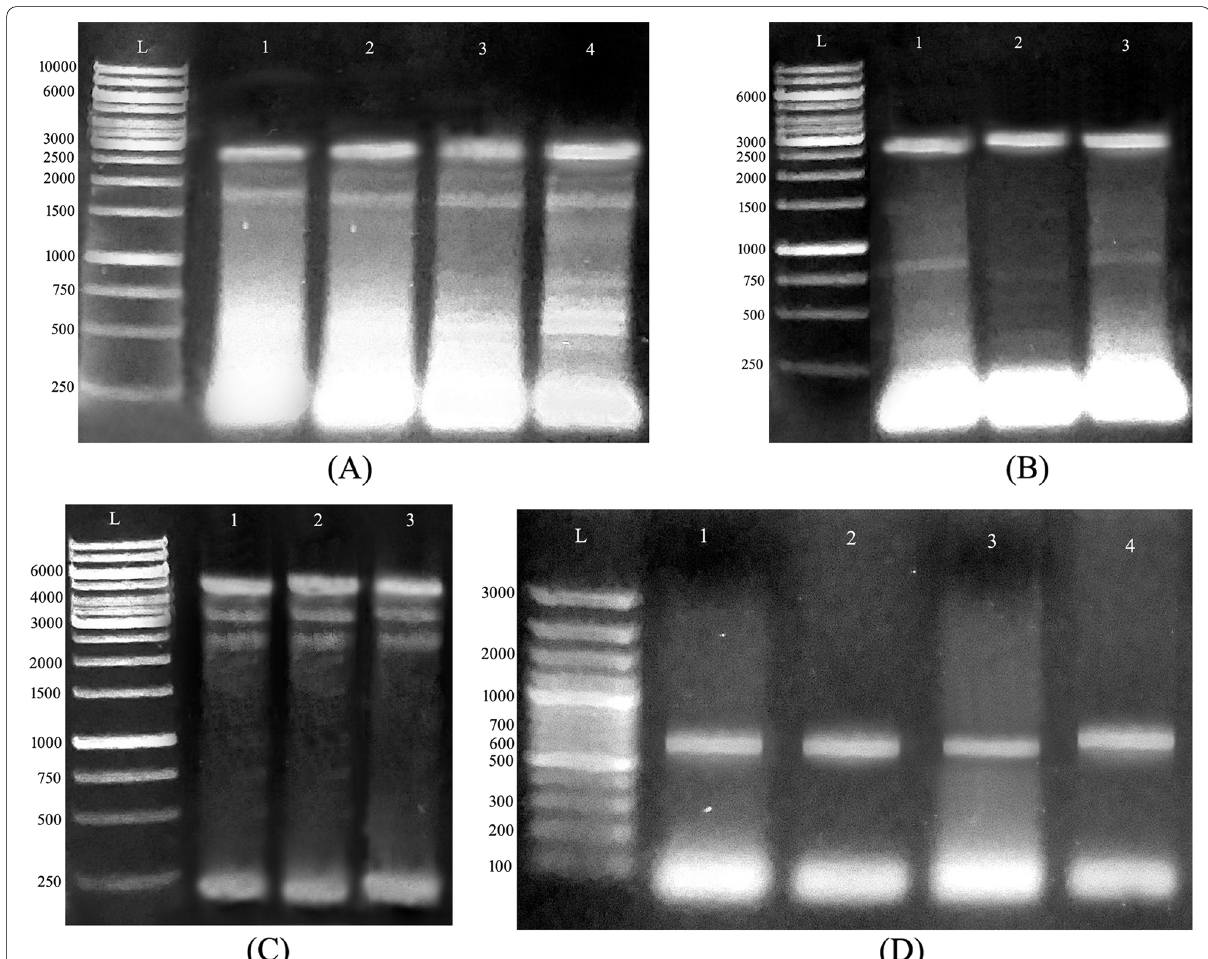
Fig. 2 Screening of bcs ‑encoding fragments in individual E. coli DH5α/BL21 (DE3) transformed colonies using vector/amplification primers. Three‑four colonies were selected in each plate for PCR‑screening, and the individual fragments bcs A ( A ), bcs B ( B ), bcs C ( C ), and bcs D ( D ) were detected in all of the tested transformants at M. wt of ~ 2.43 kb, 2.6 kb, 4.1 kb, and 672 bp, respectively. Lane (L) refers to Generuler1kb plus